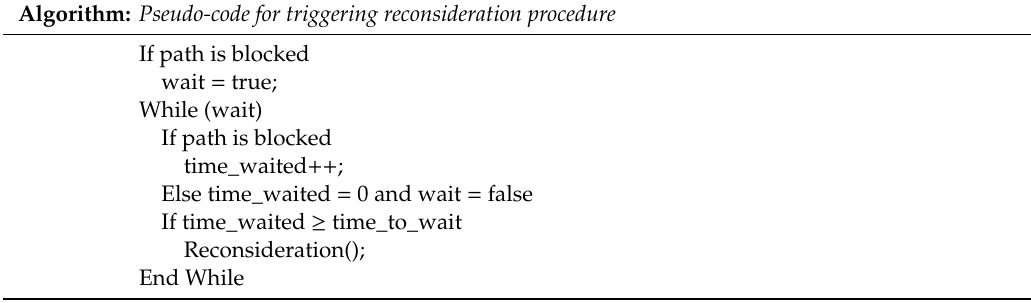
Table A2. Pseudo-code for triggering reconsideration procedure.